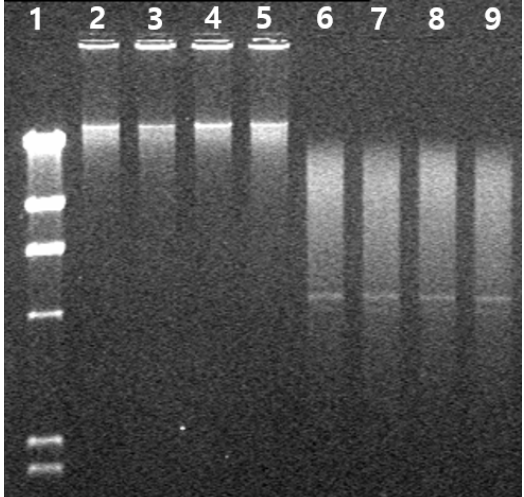
Figure 8. DNA fragmentation of human breast (MCF-7) and intestinal (Caco-2) cancer cell lines by treatment of mixture of five surfactin isoforms of cheonggukjang (MSIC): Line 1, size marker; line 2 and 3, MCF-7 cells (control); line 4 and 5, Caco-2 cells (control); line 6 and 7, MSIC-treated MCF-7 cells (100 μ g/ μ L); and line 8 and 9, MSIC-treated Caco-2 cells (100 μ g/ μ L).